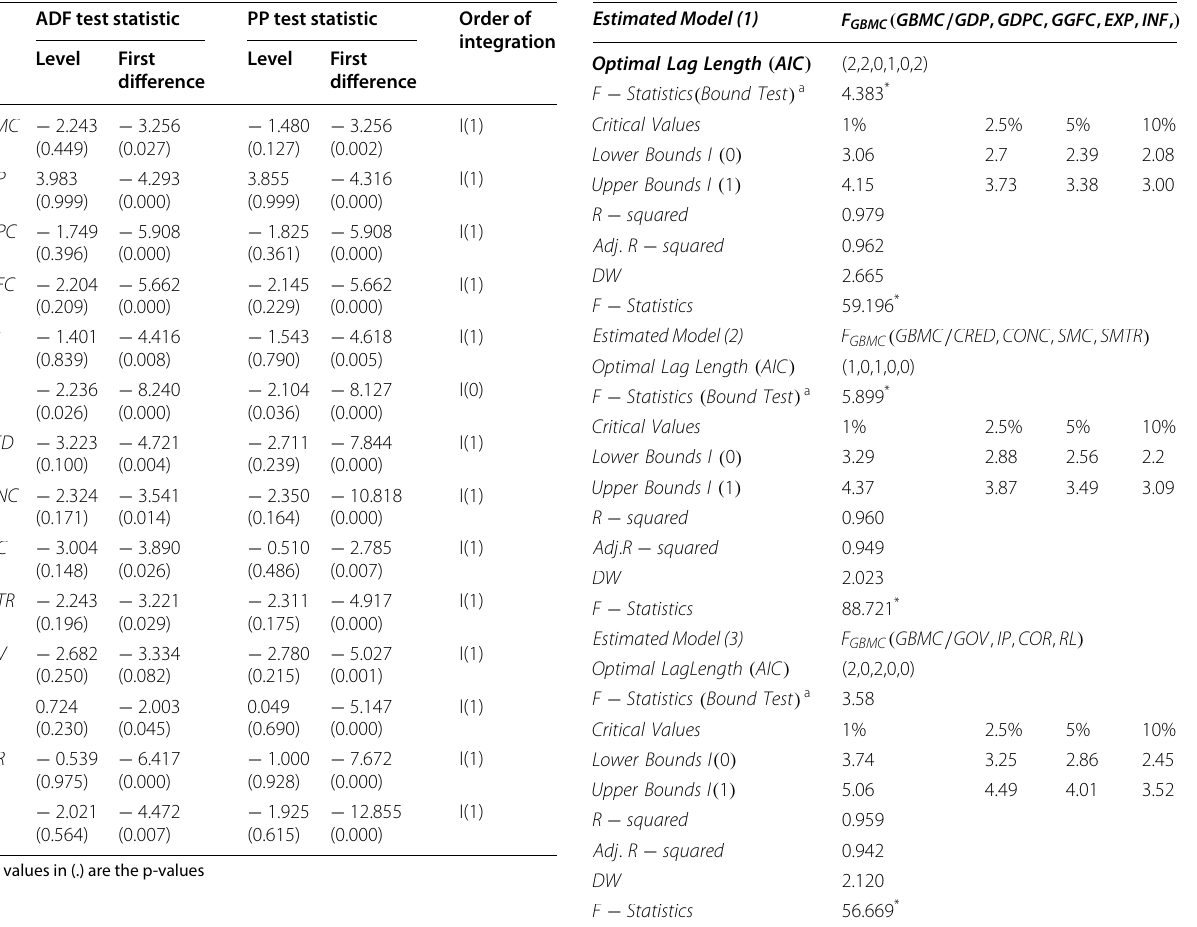
Table 2 Results of ADF and PP unit root tests